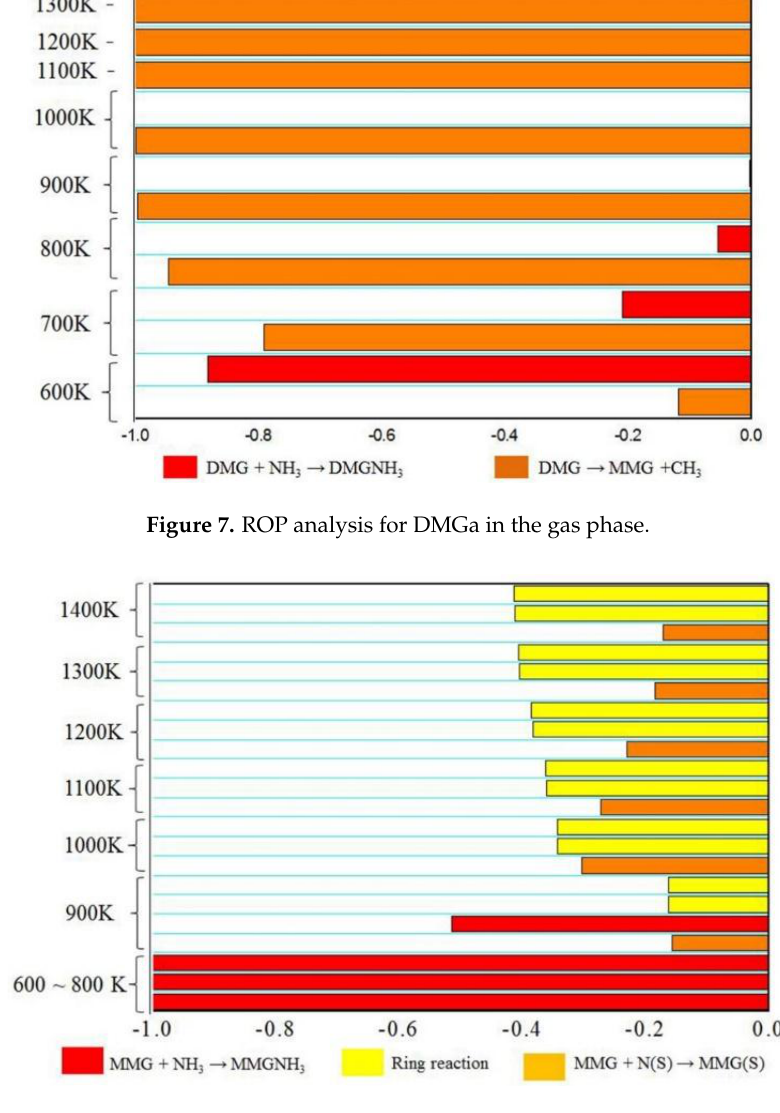
Figure 8. ROP analysis for MMGa in the gas phase.